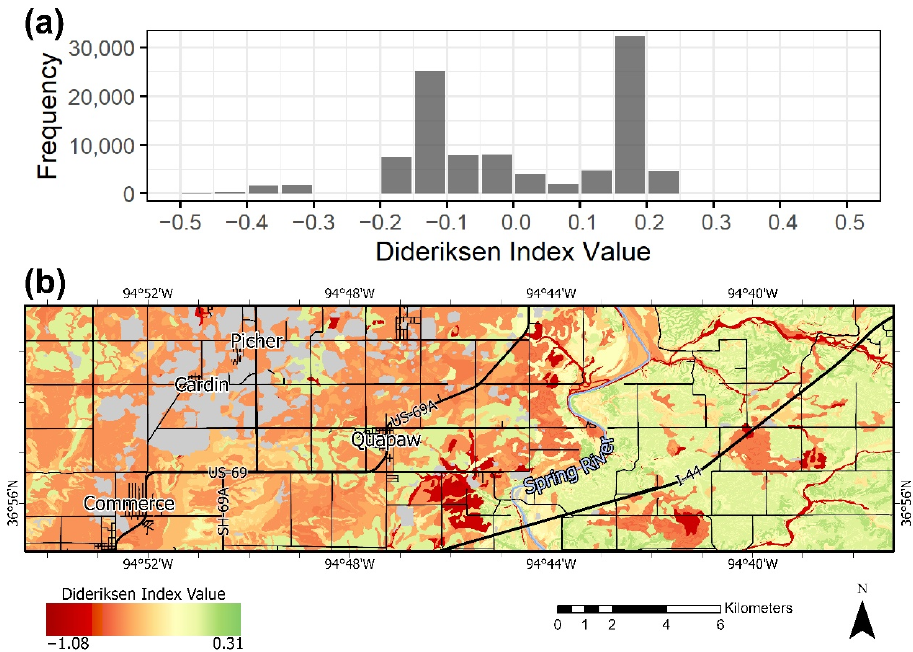
Figure 1. ( a ) Frequency distribution of Dideriksen crop suitability index values for soils within Quapaw Tribal lands and ( b ) the spatial distribution of Dideriksen index values.